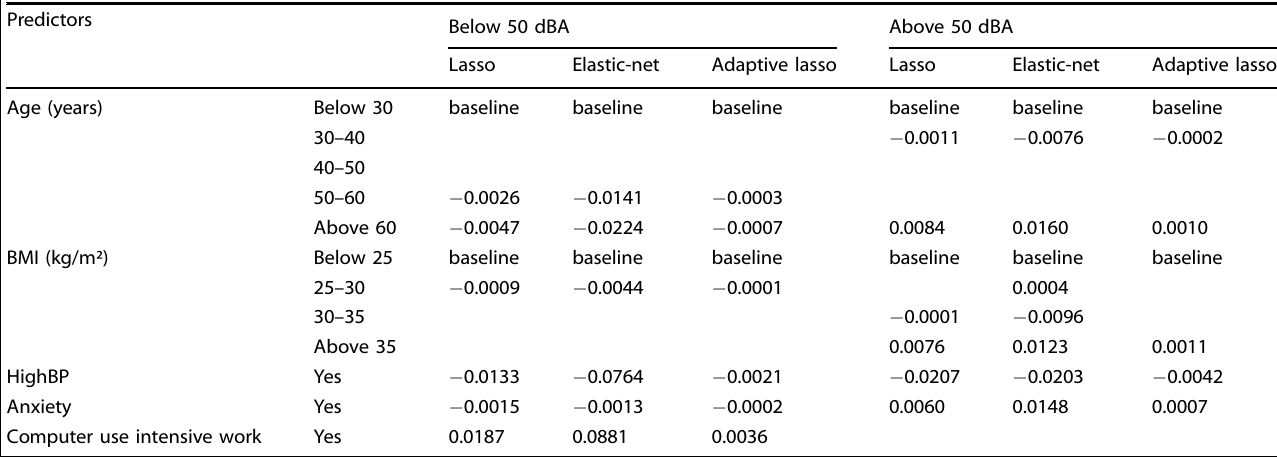
Table 4. Coef fi cients of person-level input variables contributing to heterogeneity. Predictors